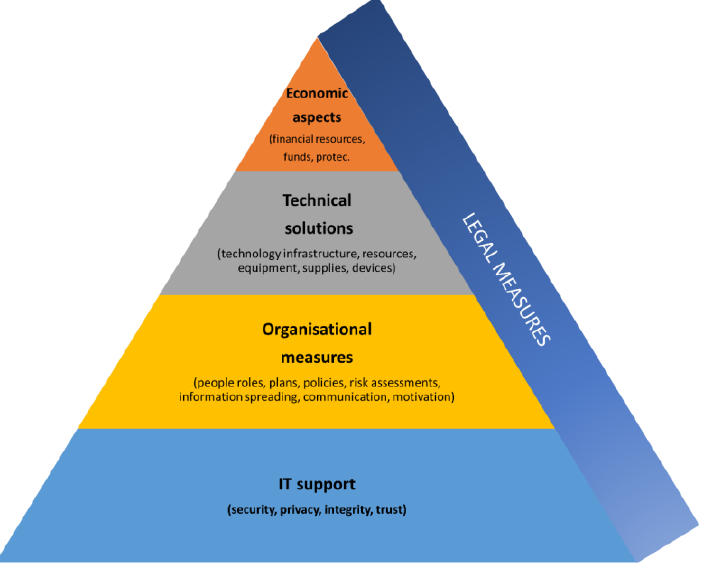
Figure 5: Structure of IT-Supported System for Security Capacity Building (Source: Authors’ research)